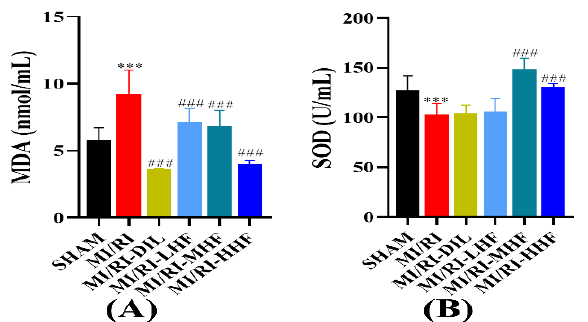
Figure 6. Effects of HF on MDA and SOD. ( A ) MDA( n = 15~16). ( B ) SOD ( n = 15~16). Results were expressed as mean ± SD. *** p < 0.001 vs. SHAM group. ### p < 0.001 vs. MI/RI group.